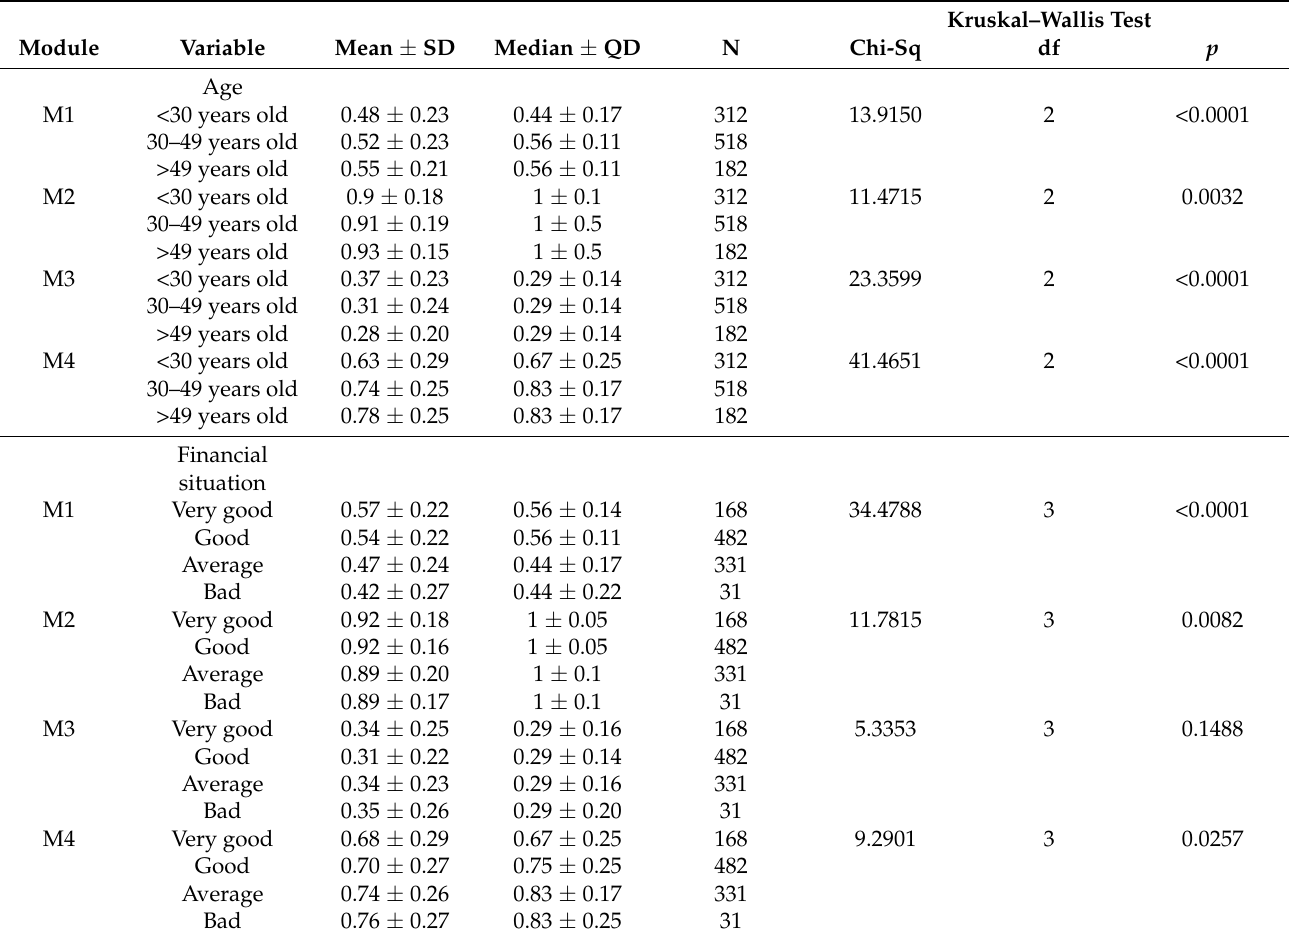
Table 4. Comparison of the answer of the given question (module M1–M4) with age and financial situation.